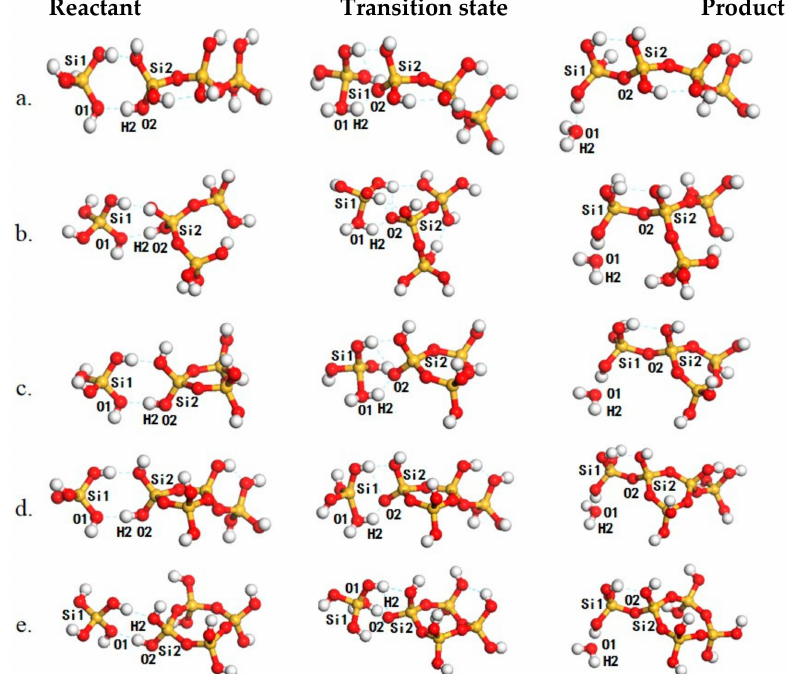
Figure 2. The structures of reaction species, including reactants ( left panel ), transition states(middle panel) and products ( right panel ) for oligomerization for the formation of T 4 ( a ), T 1 and C 1 ( e ). The Si, O and H atoms are in yellow, red and white, 4